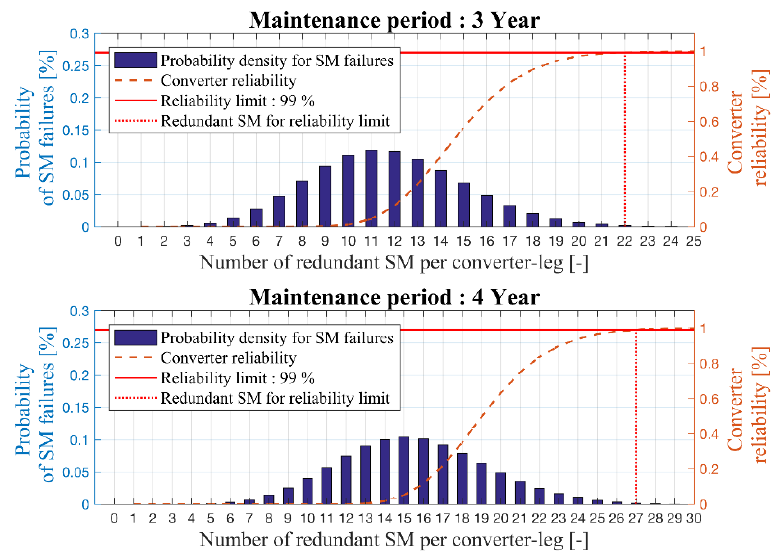
Figure 5. Converter reliability and probability of SM failure over the number of redundant SMs after the three and four year maintenance period.